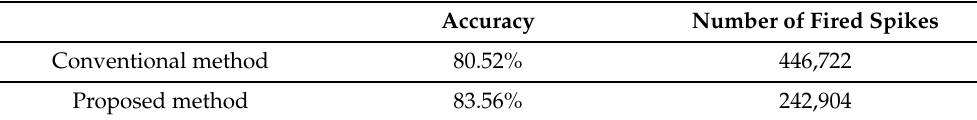
Figure 6. Graph showing the change in the total number of fired neurons according to the change of ( a ) V th and ( b ) g t . Sens Table 3. Simulation results of the accuracy and number of fired spikes for the conventional and proposed